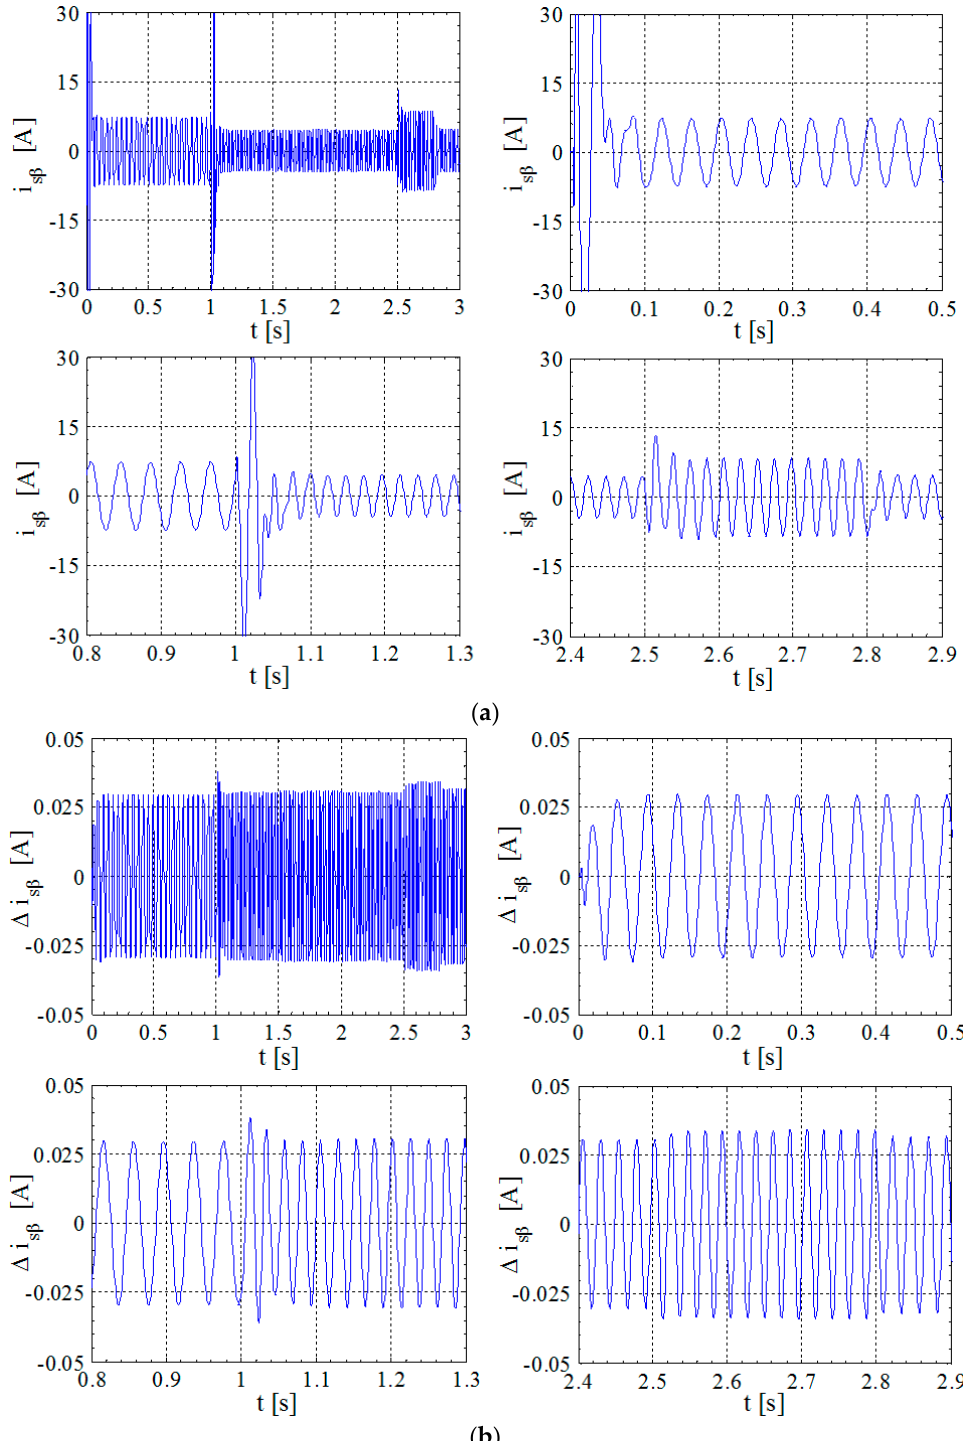
Figure 9. Observation response of β -axis stator current: ( a ) Observed β -axis current; ( b ) Observation error of β -axis current.